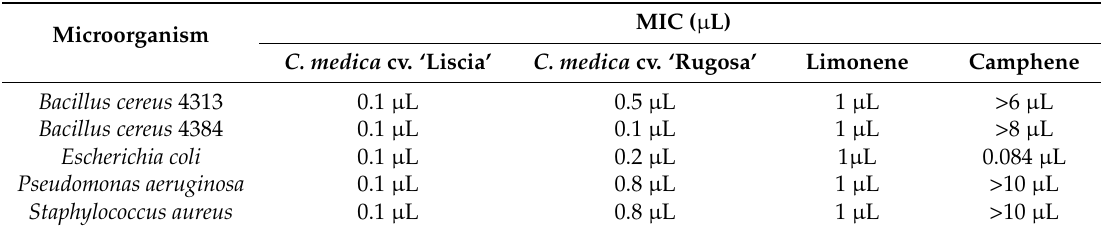
Figure 2. Antibacterial activity of EO of Citrus medica cv. ‘rugosa’ and of the reference compounds, gentamicin and tetracycline. Results are the mean of three experiments. Dunnett’s test vs. gentamicin 8 μ g: **** p < 0.0001; *** p < 0.001; * p < 0.05; Dunnett’s test vs. tetracycline 7 μ g: **** p < 0.0001; *** p < 0.001; * p < 0.05. Table 2. Minimal inhibitory concentration (MIC, μ L) of the EOs of Citrus medica cv. ‘liscia’ and cv. Table 2. Minimal inhibitory concentration (MIC, µ L) of the EOs of Citrus medica cv. ‘liscia’ and cv. ‘rugosa’ and of their main components, limonene and camphene. ‘rugosa’ and of their main components, limonene and camphene.